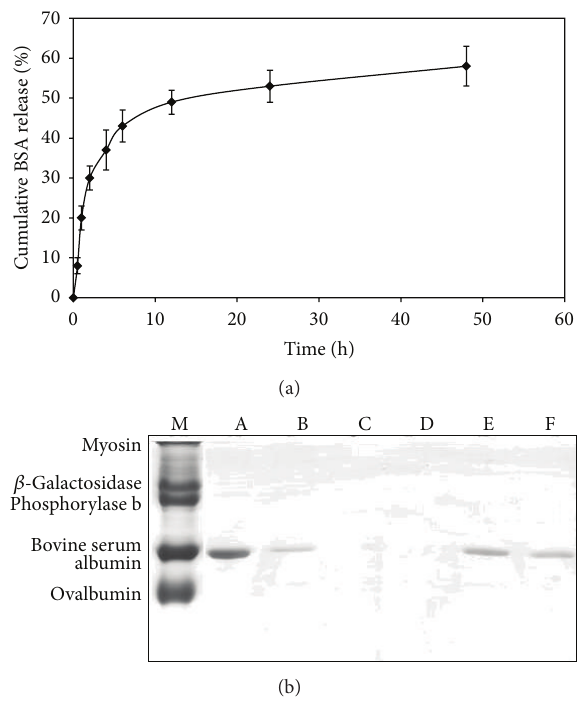
Figure 5: (a) The release profile of BSA loaded CS NPs at DS :CS ratio of 1:1 at pH 7.4, 𝑛 = 3 . (b) SDS-PAGE analysis of BSA released from CS NPs: (M) SDS-PAGE standards (BIO-RAD); (A)